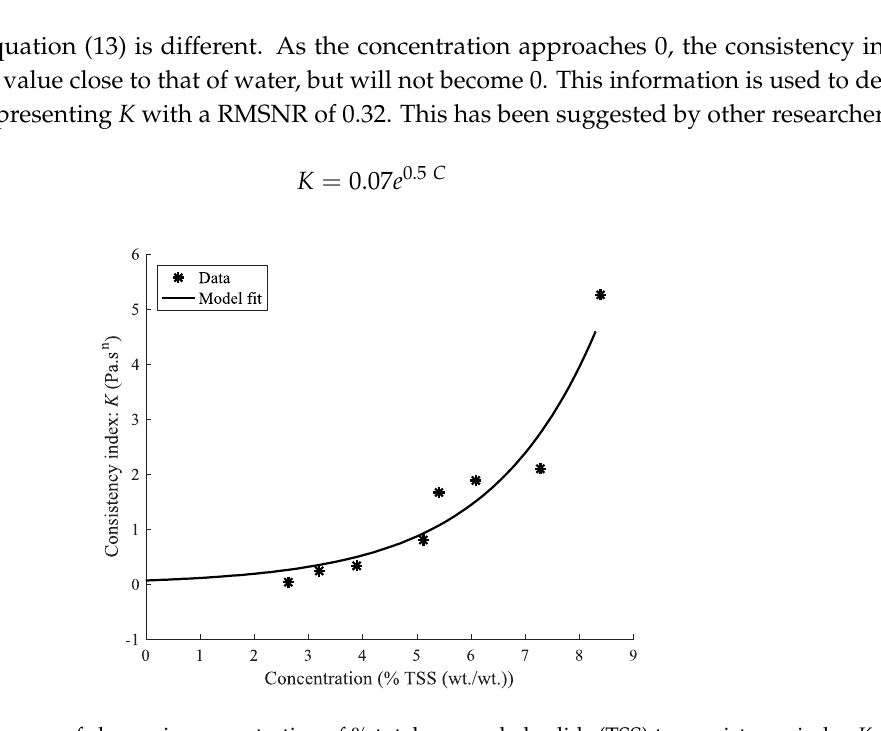
Figure 7. Influence of change in concentration of % total suspended solids (TSS) to consistency index K of concentrated domestic slurries (CDS).